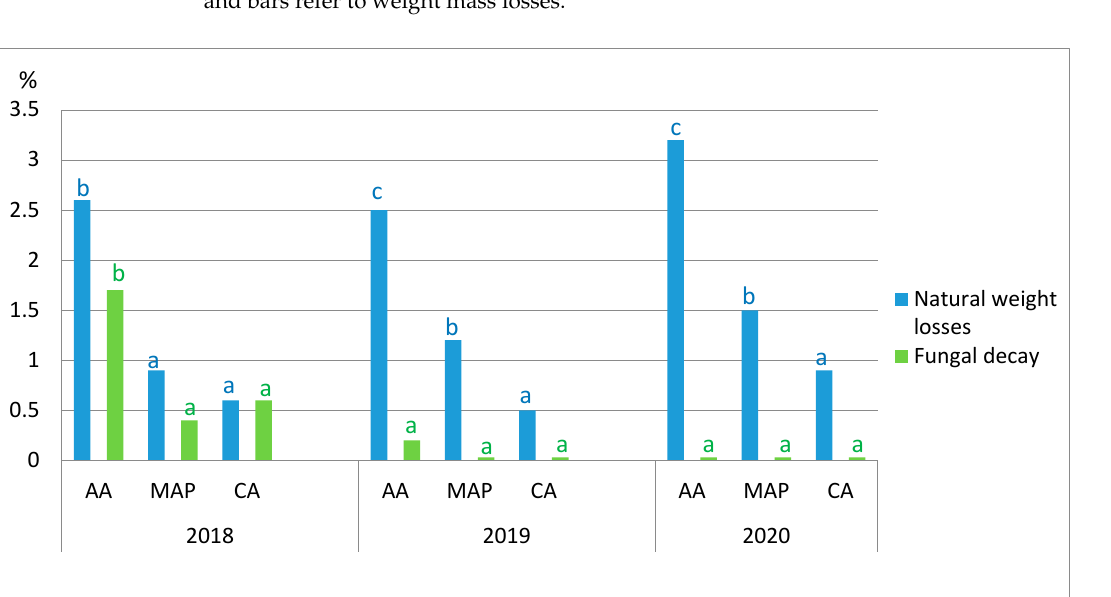
Figure 2. Natural weight losses (%) and fungal decay (%) of ‘San Andreas’ strawberries as affected by storage conditions. Bars characterizing fungal decay should be green (like the letters) blue letters and bars refer to weight mass losses.